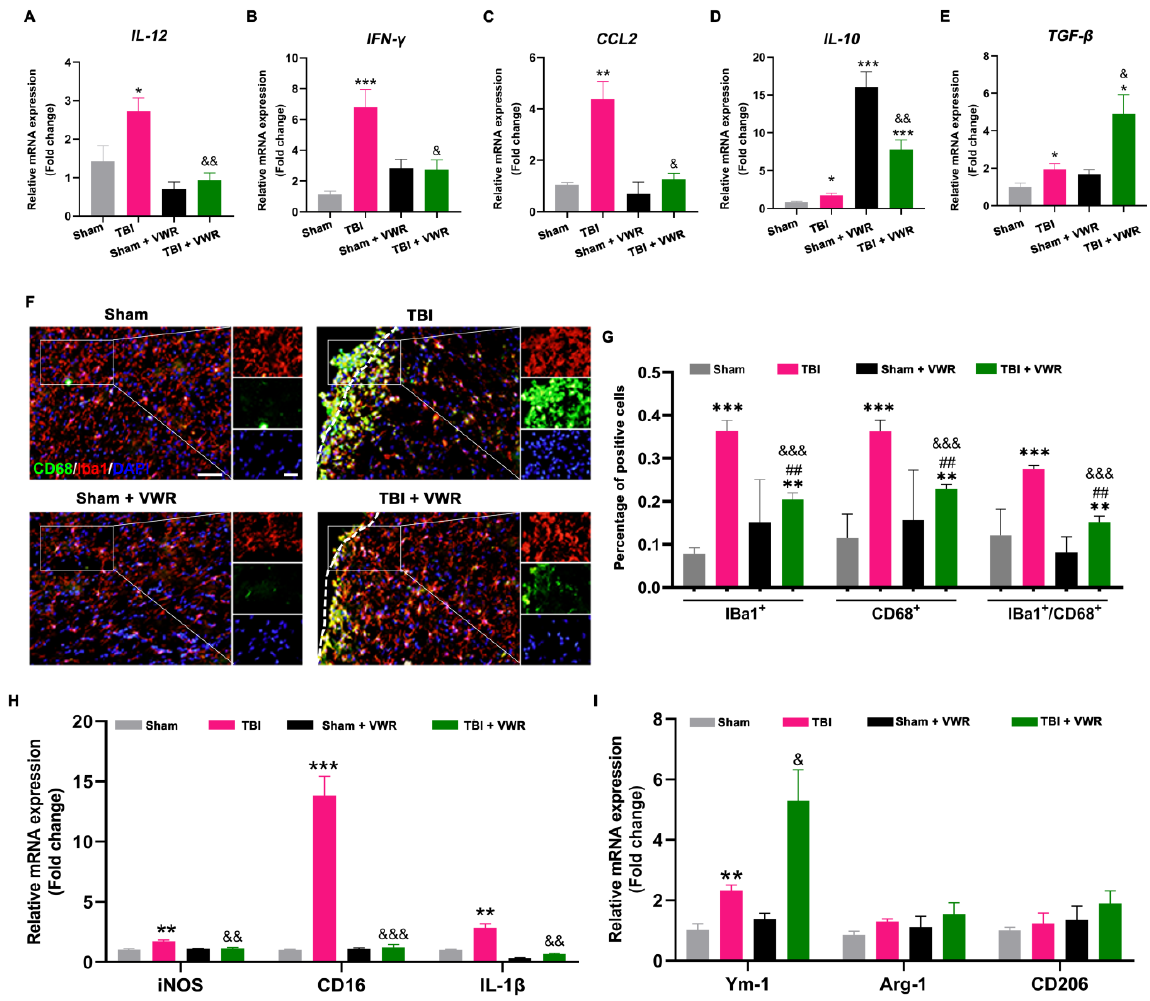
Figure 3. VWR reduced the inflammatory response after TBI. ( A – C ) The mRNA expression of pro-inflammatory factors in the perilesional cortex, including IL-12, IFN- γ , and CCL2, significantly increased after TBI and decreased after VWR. ( D , E ) The mRNA expression of anti-inflammatory factors, including IL-10 and TGF- β , increased after TBI and VWR. However, the VWR-induced increase of IL-10 was independent of TBI. ( F , G ) The activation of microglia in the perilesional cortex was noticed after TBI and significantly reduced after VWR, showed by the percentage of Iba1 + , CD68 + and Iba1 + /CD68 + cells. ( H ) The mRNA expression of iNOS, CD16, and IL-1 β (M1 mi- croglia markers) in the perilesional cortex significantly increased after TBI and decreased after VWR. ( I ) The mRNA expression of Ym-1 (M2 microglia markers) significantly increased after TBI and was further enhanced after VWR. While the expression of Arg-1 and CD206 (M2 microglia mark- ers) slightly increased after TBI but significantly up-regulated in TBI + VWR mice. *** p < 0.0001, ** p < 0.001, * p < 0.05 vs. Sham. &&& p < 0.0001, && p < 0.001, & p < 0.05 vs. TBI. ## p < 0.001 vs. Sham + VWR. One-way ANOVA, Post hoc Sidak’s multiple comparisons tests; n = 4. Iba1: red; CD68: green; DAPI: blue; scale bar = 100 µ m. VWR, voluntary wheel running; TBI, traumatic brain injury; IL-12, interleukin 12; IFN- γ , interferon γ ; CCL2, the C-C motif chemokine ligand 2; IL-10, interleukin 10; TGF- β , transforming growth factor- β ; Iba1, Ionized calcium-binding adaptor molecule